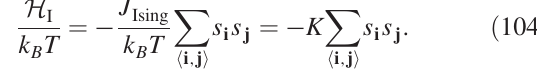
around the perpendicular direction. The numerically calcu- lated scattered light intensity at different temperatures is shown in Figs. 10(a) – (c). The average value of the order parameter m is smaller than 0.02 in all the cases. The average scattered light intensity grows at temperatures close to the transition [Fig. 10(d)], and the magnetic Bragg peaks emerge as the correlation length increases. The large fluctuations between different realizations in the simplified model (Fig. 10) are likely to significantly overestimate the fluctuations of the true AFM state.